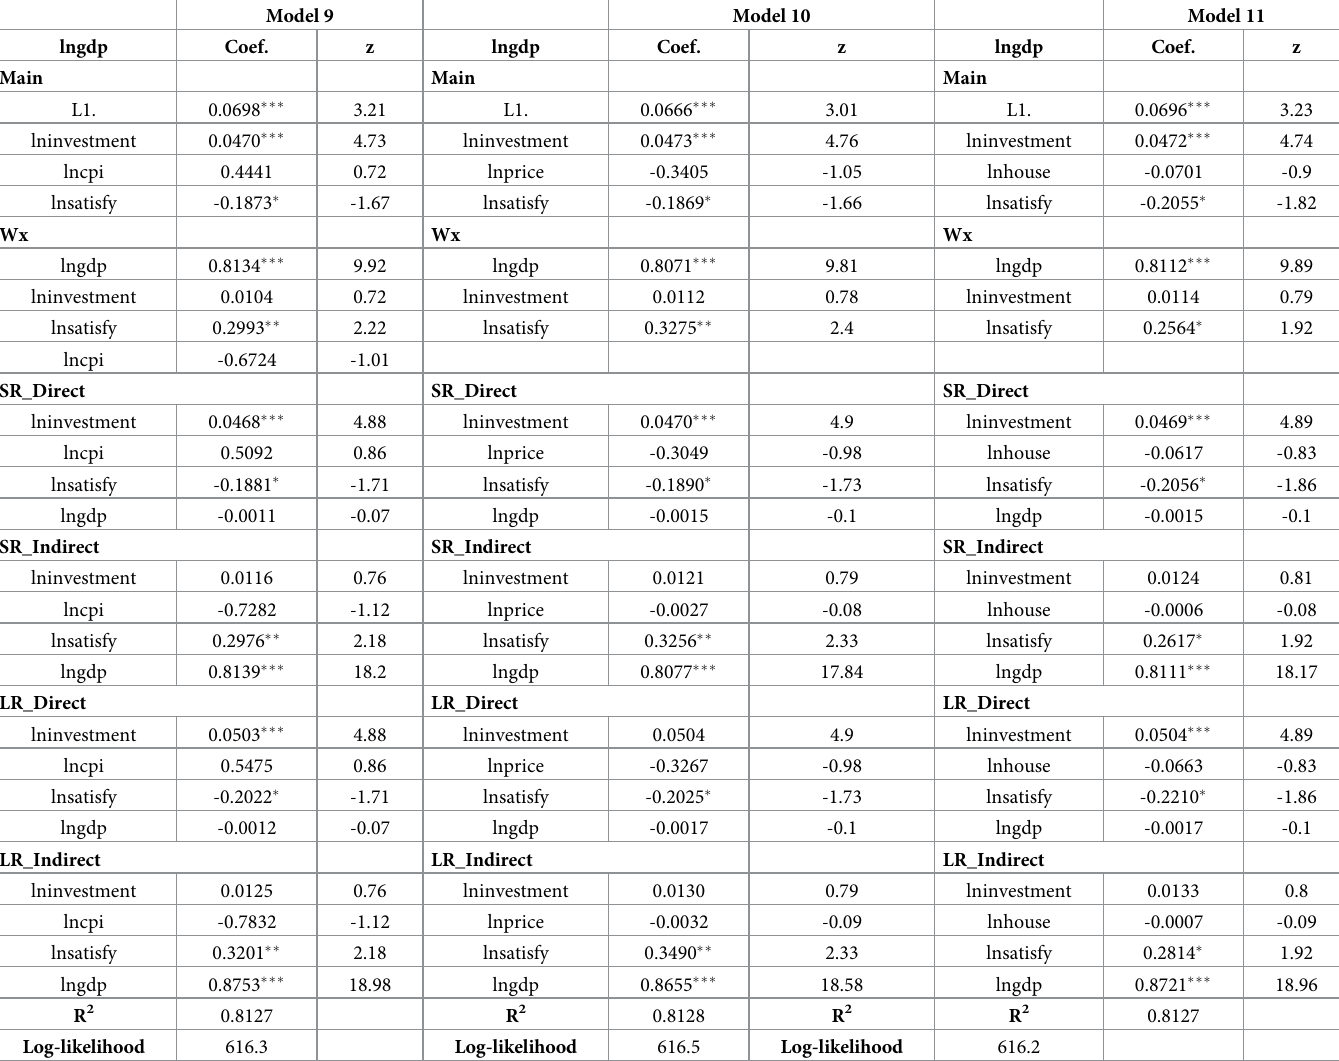
Table 10. SDM_Lag regression results for urban tourist satisfaction and urban GDP